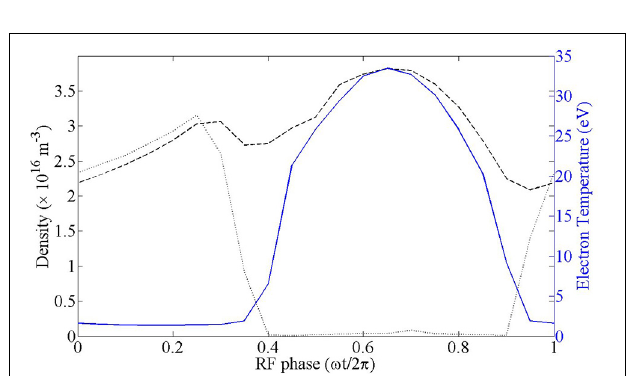
FIGURE 6 | Phase resolved voltage at x = 11mm on the rf electrode (solid blue line), inner alumina tube surface (dashed green line) and plasma potential on the central axis of the tube (dotted red line) over two rf cycles. Phase averaged plasma potential on the central axis is shown as the straight red dotted line and phase averaged inner alumina tube surface voltage is shown as the straight dashed green line.